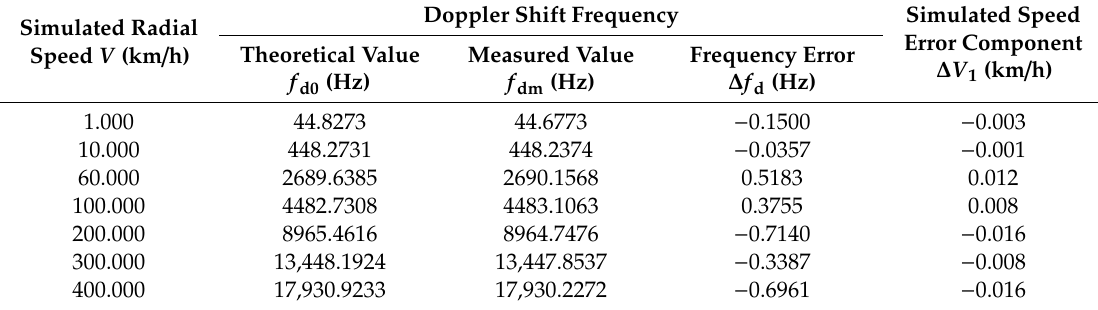
Table 2. Doppler shift frequency error and simulated speed error component in the accuracy aspect of the first moving target simulator at emitted frequency of 24,190 MHz.